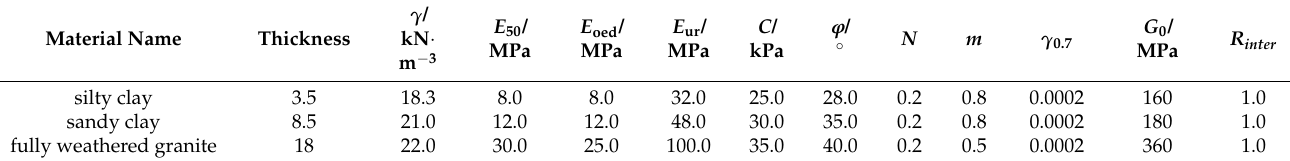
Table 3. Parameters of the soil in simulation.